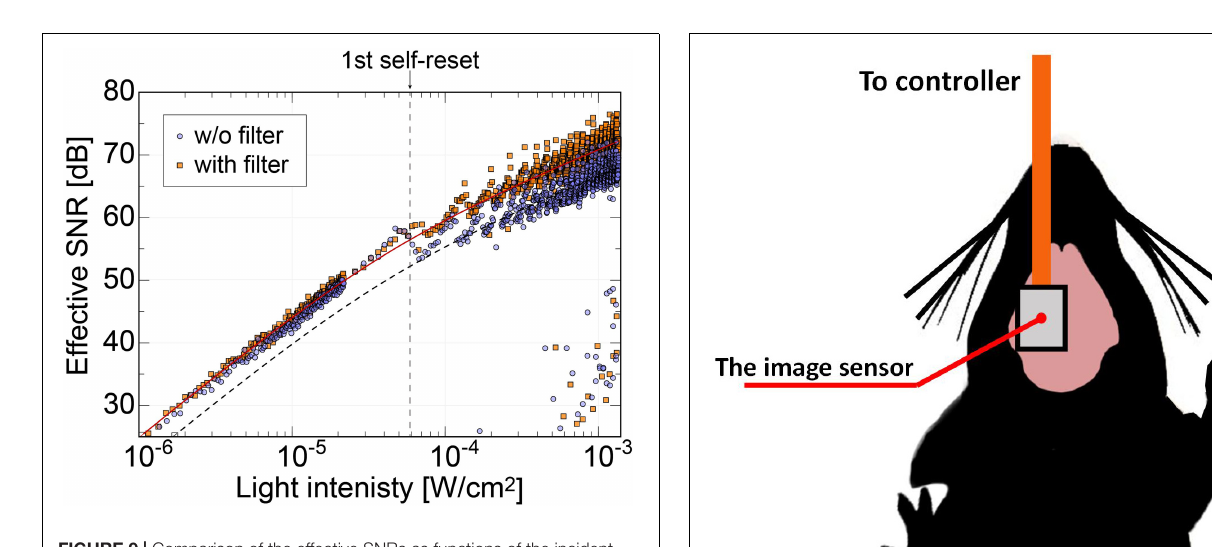
FIGURE 9 | Comparison of the effective SNRs as functions of the incident light intensity between the image sensor using relay boards with and without the noise filter on the Vrst line. The result shows that the SNR dropping behavior at the first self-resetting has been reduced with our latest relay board.